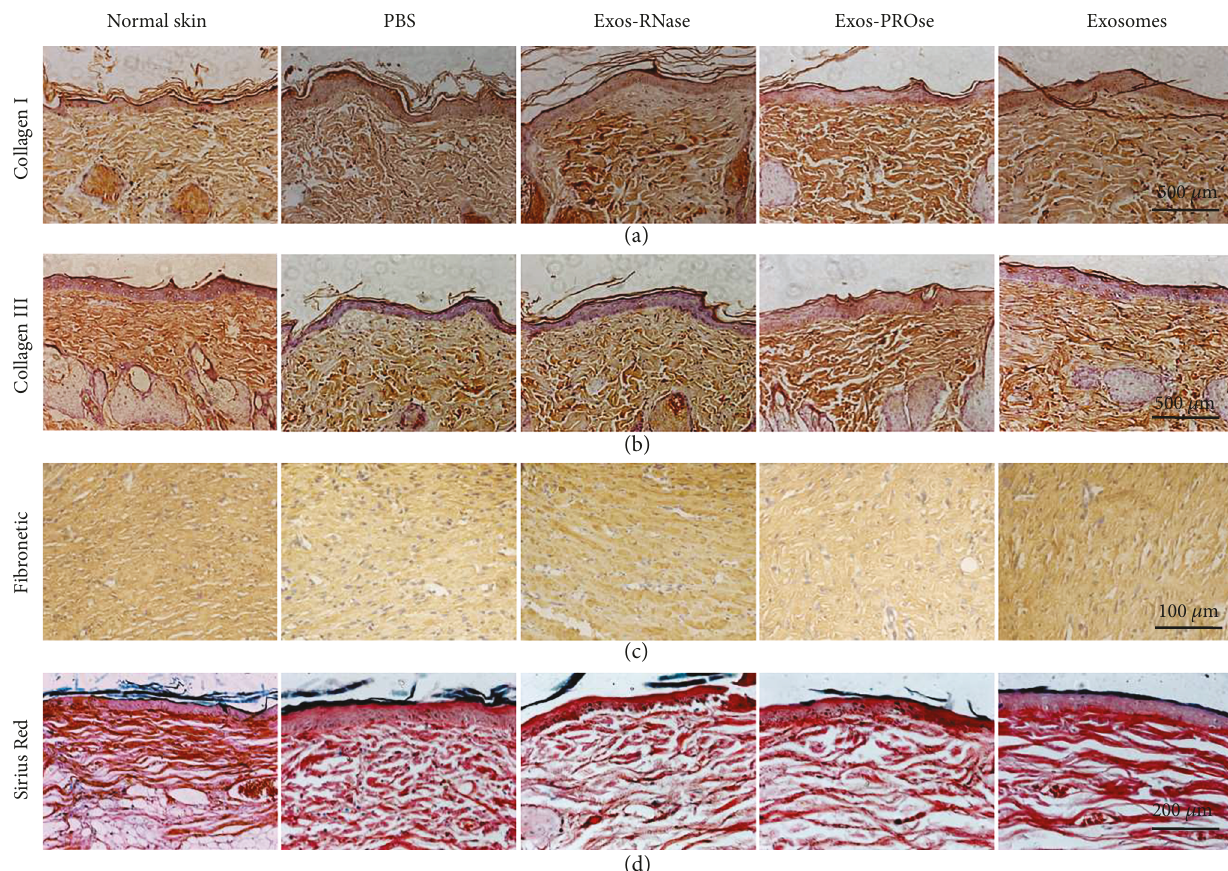
Figure 6: Collagen arrangement after wound healing. The IHC of collagen-I (a), collagen-III (b), and fi bronectin (c) in wounded skin sections on day 30 postwounding. Scale bar =500 μ m or Scale bar =100 μ m ( n = 5 ). (d) Sirius Red staining of collagen fi bers on day 30 postwounding. Scale bar =200 μ m ( n = 5